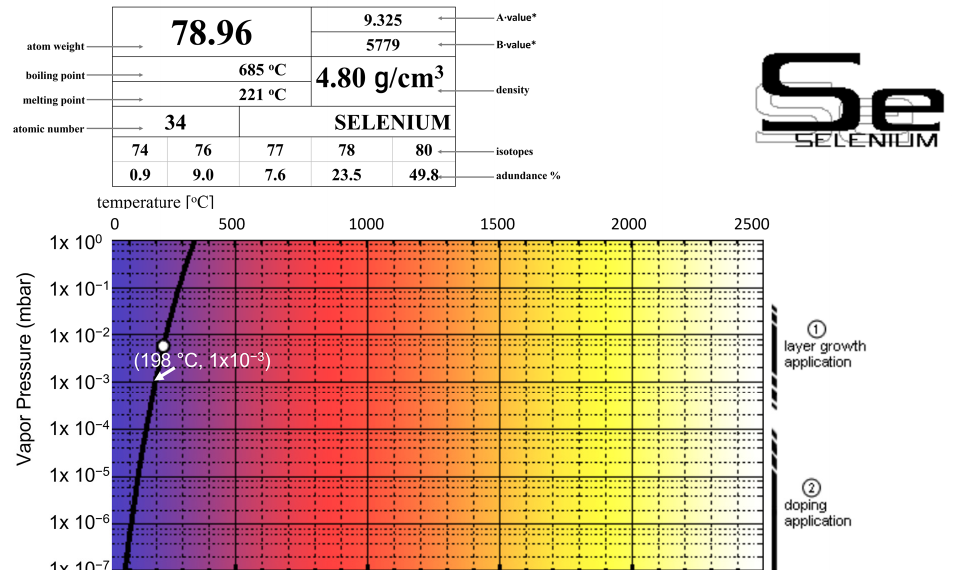
Figure A2. The temperature dependent vapor pressure of Se.